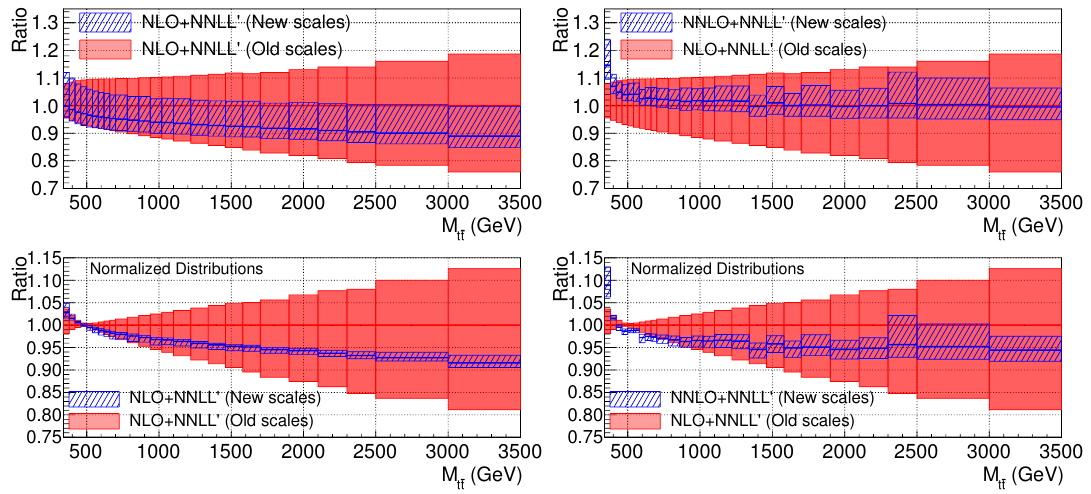
Figure 10 . Comparison of the 3 results for the absolute (upper) and normalized (lower) M distributions: 1) NLO+NNLL 0 with old scales (red bands); 2) NLO+NNLL 0 with new scales (blue bands on the left side); 3) NNLO+NNLL 0 with new scales (blue bands on the right side). They are all normalized by the central values of